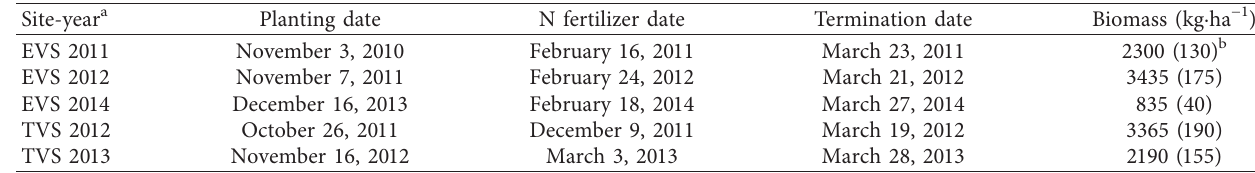
Table 1: Planting dates, N fertilizer application dates, termination dates, and aboveground biomass measured for a rye (“Wrens Abruzzi”) cover crop at five site-years during the 2011 to 2014 growing seasons across northern and central Alabama.